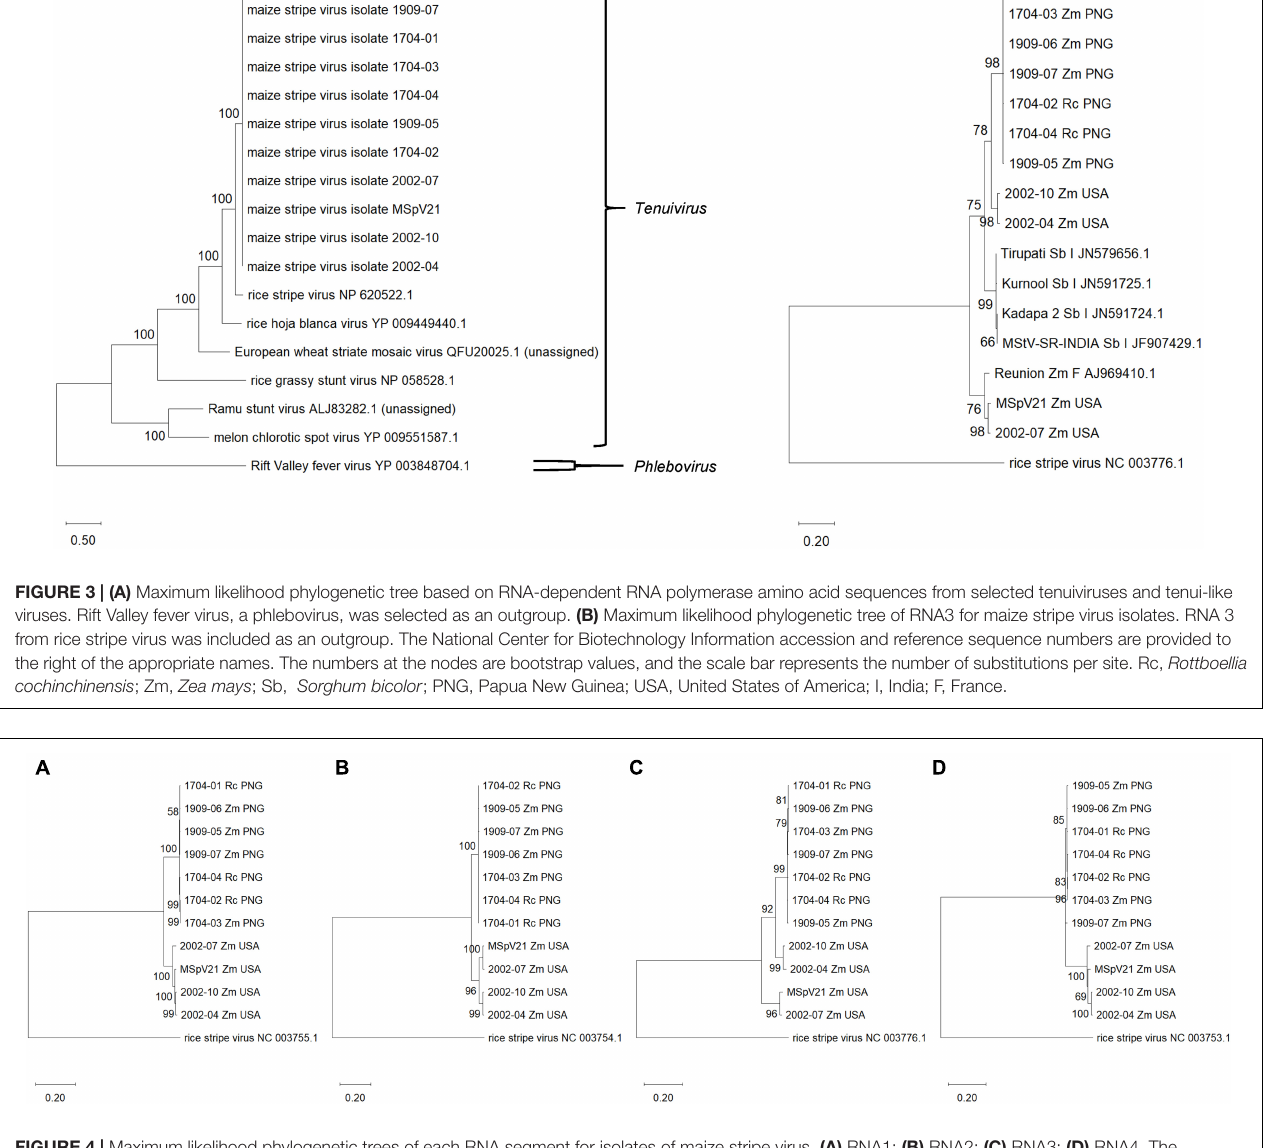
FIGURE 4 | Maximum likelihood phylogenetic trees of each RNA segment for isolates of maize stripe virus. (A) RNA1; (B) RNA2; (C) RNA3; (D) RNA4. The respective RNA segments from rice stripe virus were included as outgroups, and the corresponding National Center for Biotechnology Information reference sequence numbers are provided for these. The scale refers to the number of substitutions per site, and the numbers at the nodes are bootstrap values. Rc, Rottboellia cochinchinensis ; Zm, Zea mays ; PNG, Papua New Guinea; USA, United States of